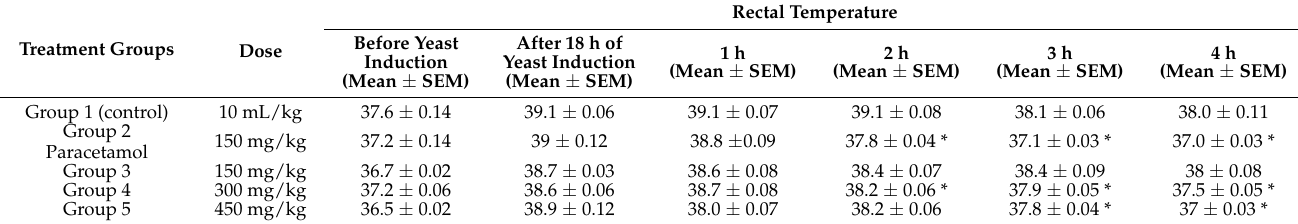
Table 3. Antipyretic potential in methanolic extracts of different doses. All treatments consist of 5 groups. Each group has 3 replicates. Each group of mice was treated with a different methanolic extract/dose. The expression of value was mean ± SEM based. The mean difference was considered statistically significant at the 0.05 level. Significance indicated (* p < 0.05).